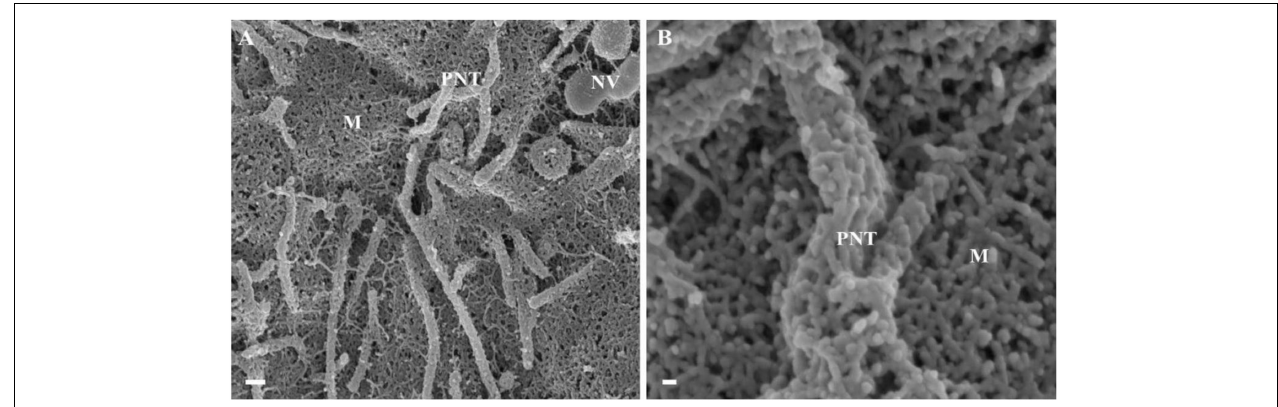
FIGURE 3 | The de novo formation of primordial nanotubules on the membrane surface of BECs. (A) Depicts a micrograph showing elongated NT structures emanating from the plasmalemma of a b.End5 cell (Scale bar = 200 nm). Membranous protrusions from the cell surface morph into rope-like, tethering NTs on the apical surface of a b.End5 cell membrane. (B) Illustrates the formation of dense NT distensions’ originating from the cell membrane surface (Scale bar = 100 nm). “M,” denotes the porous membrane, “NV” denotes the nanovesicle and “PNT,” denotes the primordial nanotubule.